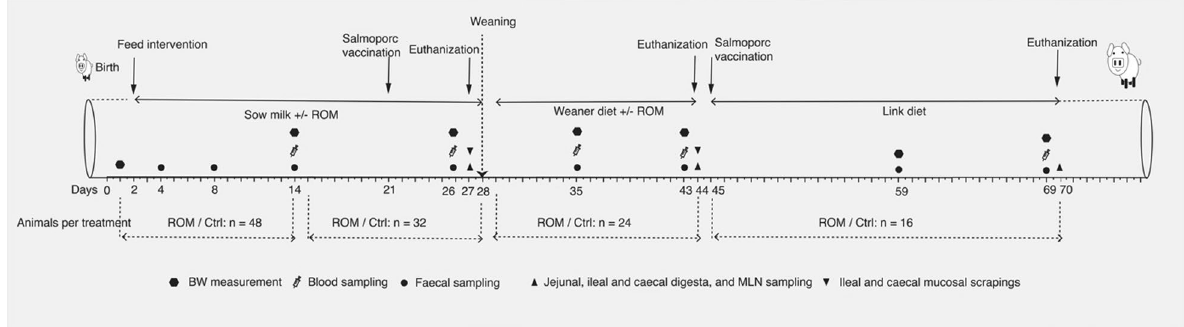
Fig. 1 Experimental set up. Piglets orally received either ROM or tap water (Ctrl group) every other day, starting from day 2 until day 44. An oral vaccine (Salmoporc ® ) was given on day 21 and day 45 (booster vaccination). A randomly selected subset of animals (eight per group) were euthanised on 3 days (days 27, 44 and 70). Body weight (BW) was monitored for pig growth performance. Faeces and digesta from jejunum, ileum and caecum were collected and processed for 16S rRNA gene sequencing. Ileal and caecal mucosa were sampled for immune gene expression analysis. Blood samples were taken to assess vaccine‑specific antibodies (IgM, IgA and IgG) against Salmonella typhimurium (Salmoporc ® ). Furthermore, blood samples were processed and evaluated for immune cells, and mesenteric lymph node (MLN) samples were re‑stimulated with the mitogen